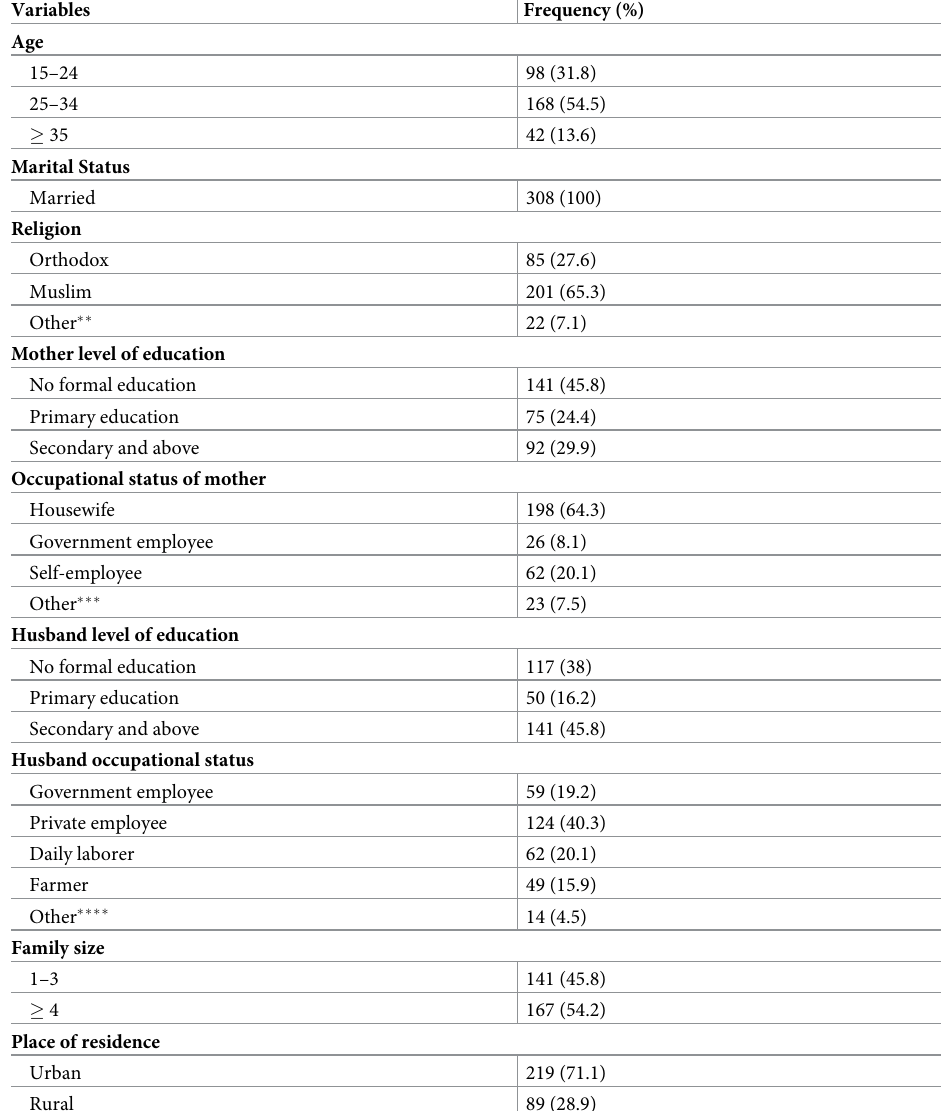
Table 1. Socio-demographic characteristics of pregnant women attending antenatal care in public health facilities Dire Dawa, Eastern Ethiopia. n =